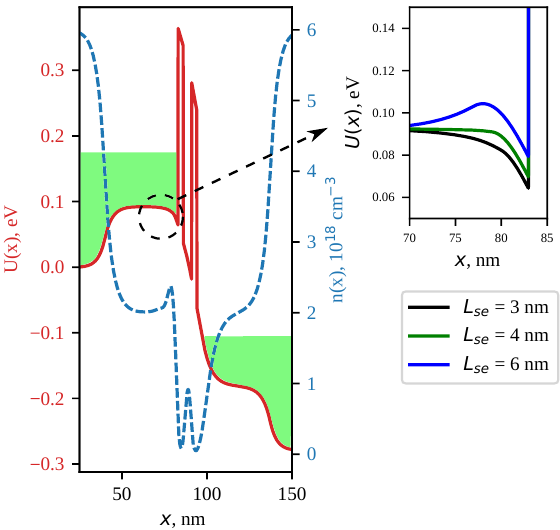
Figure 8. ( Left ) The potential of the bottom of the conduction band (right y -axis, solid curve) and electron density (left y -axis, dotted curve) depending on the coordinate for the resonant tunneling Nanostructure #1 at the applied voltage V dc = 0.29 V. The position of the Fermi level is shown by a green fill. ( Right ) The potential of the bottom of the conduction band for Nanostructure #1, maximized in the emitter spacer region, for several values of the spacer thickness.